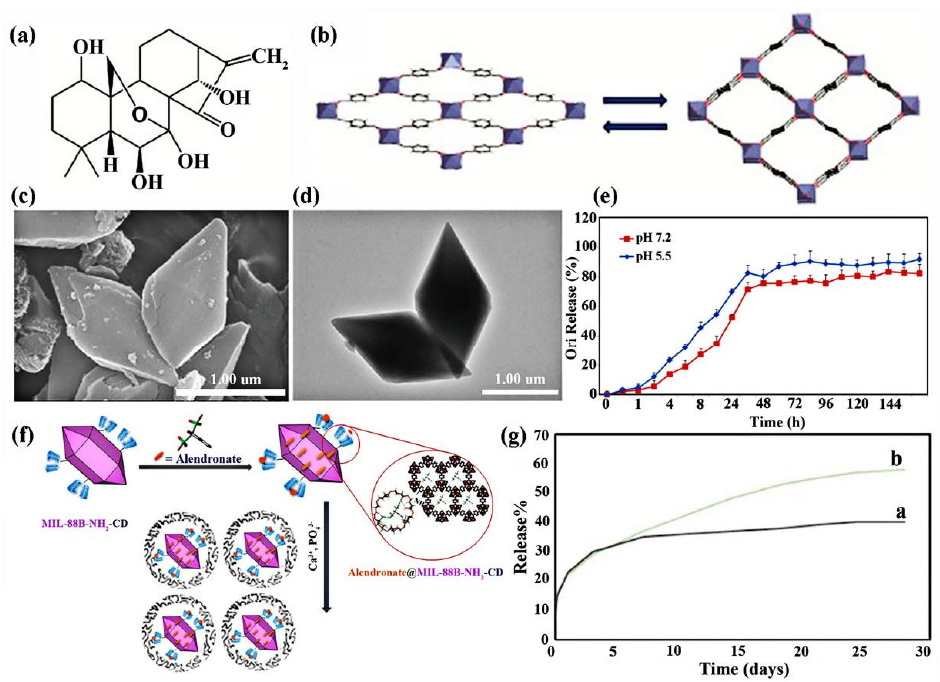
Figure 6. Structures of ( a ) Ori and ( b ) MIL-53(Fe). ( c ) SEM and ( d ) TEM images of Ori@MIL-53(Fe). ( e ) Ori release profiles of Ori@MIL-53(Fe). Reproduced with permission from Ref. [76], copyright (2018) MDPI, Basel, Switzerland. ( f ) Alen@Fe-MIL-88B-NH 2 -CD and ( g ) Alen release curves. Repro- duced with permission from Ref. [121], copyright (2018) Springer.